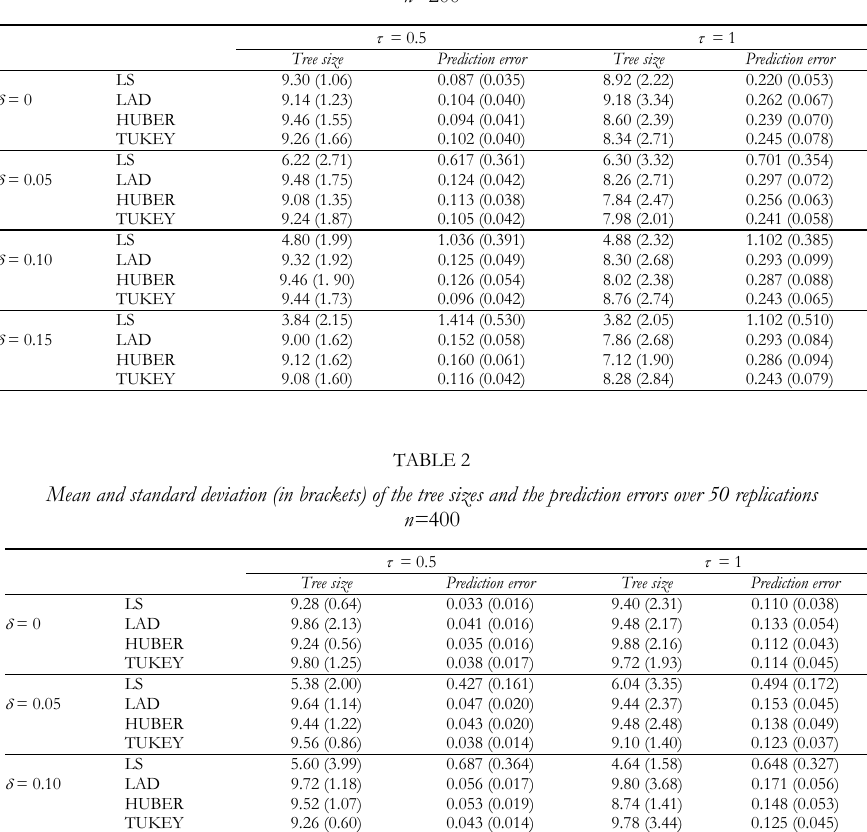
Mean and standard deviation (in brackets) of the tree sizes and the prediction errors over 50 replications n= 200